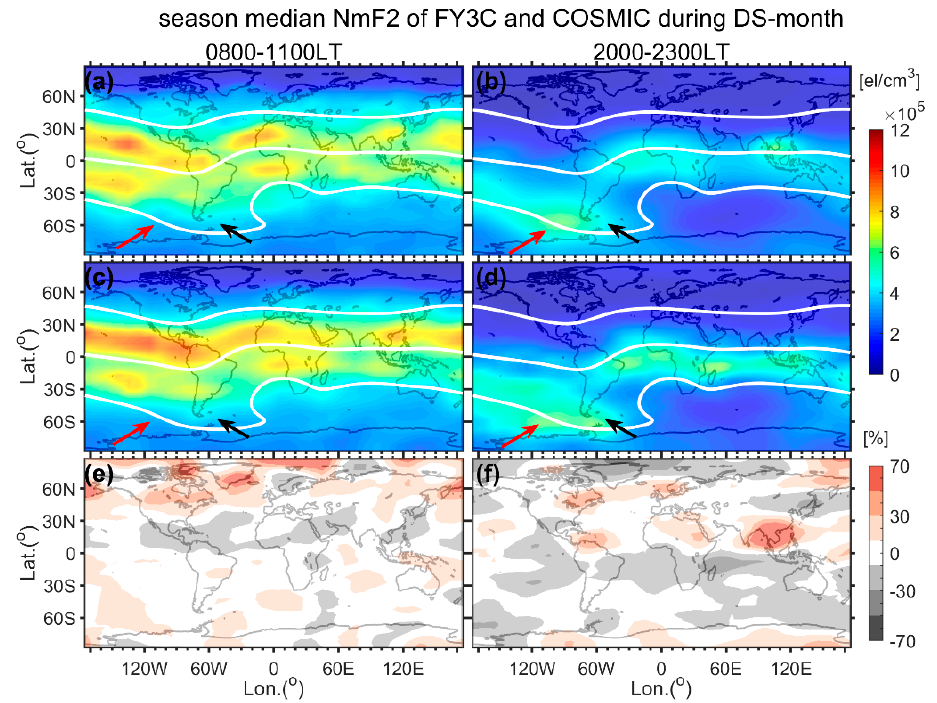
Figure 9. Ionospheric climatological characteristics of season median NmF2 observed by FY3C/GNOS and COSMIC and their differences at 0800–1100LT and 2000–2300LT during DS-month (±45 days to December solstice of 2016) from 2016.311 to 2017.035. The regions denoted by red and black arrows indicate diurnal variation of NmF2, in which the general WSA and special WSA can be observed at nighttime, respectively. Refer to Figure 6 for more detailed descriptions.